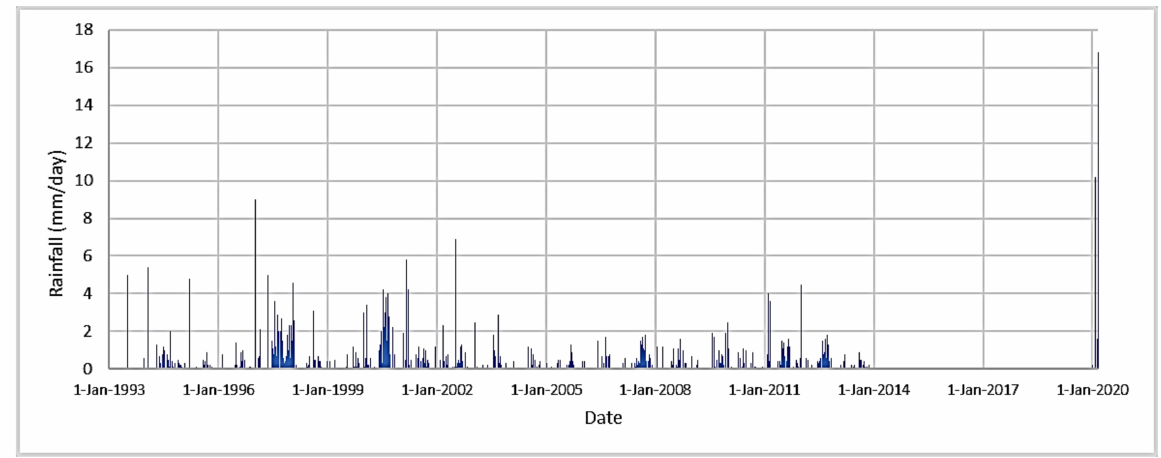
Figure 2. Total daily precipitation—JORGE BASADRE rain